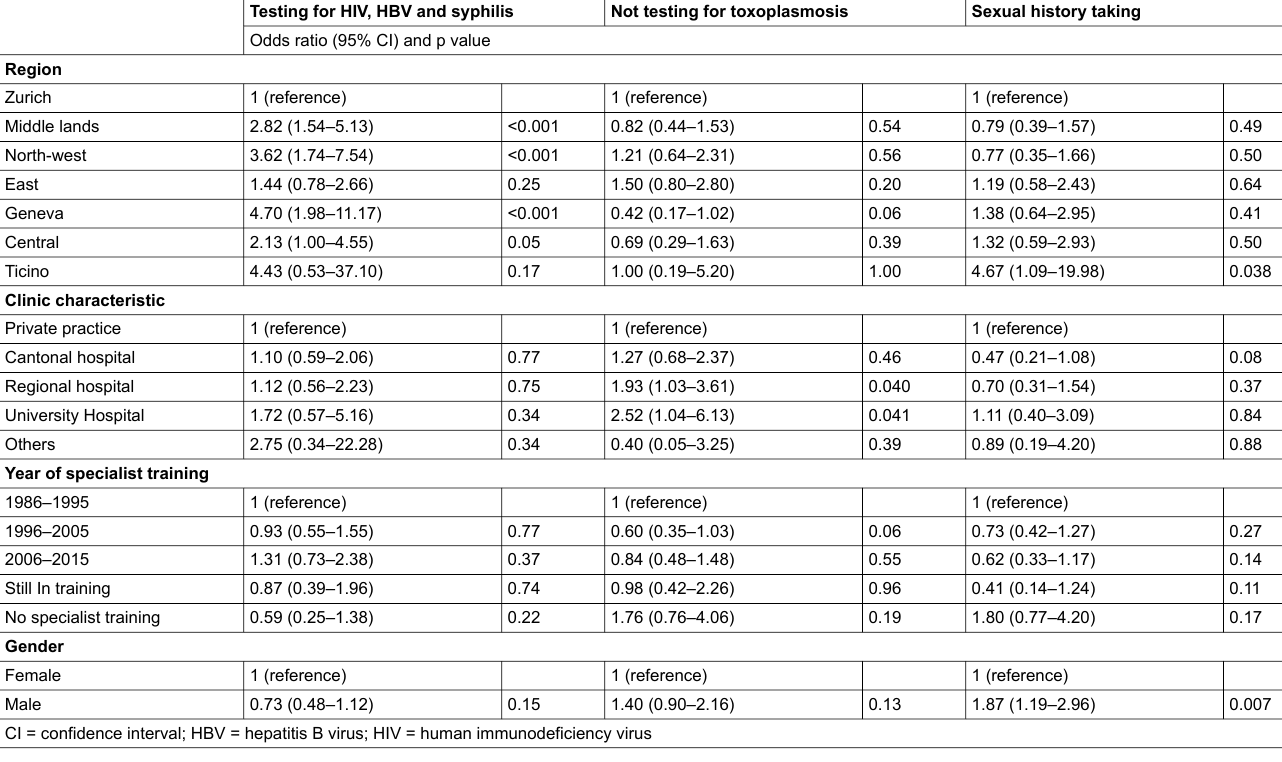
Table S1: Univariable logistic regression models for testing for HIV, HBV and syphilis, not testing for toxoplasmosis and taking a sexual history, according to region, clinic characteristic, year of specialist training and gender.. Testing for HIV, HBV and syphilis Not testing for toxoplasmosis Sexual history taking